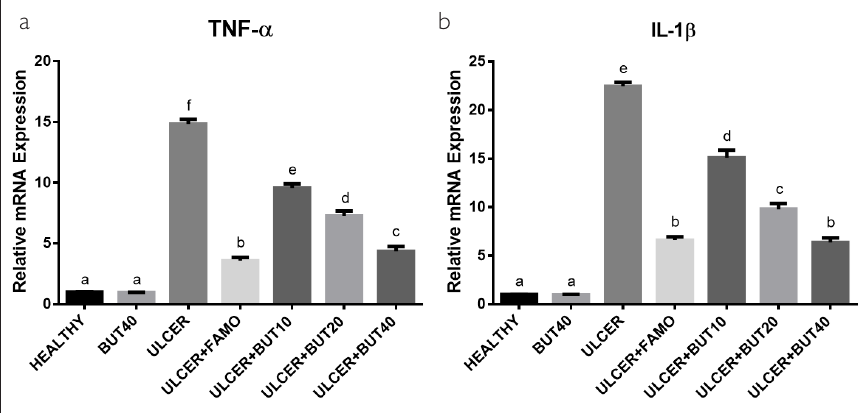
Figure 4. a, b. Stomach tissue TNF- α (a) and IL-1 β (b) mRNA expression. Means with the same letter are not significantly different; means with different letters indicate significant differences between the groups according to the Duncan test (p <0.05). Results are mean±SD. N=¼ 6 animals per